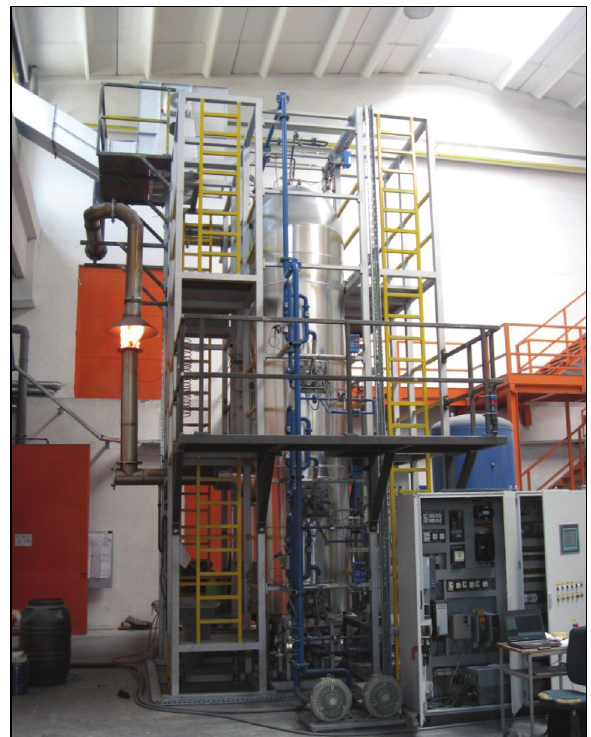
Fig. 2. The 750 kW semi-industrial plant. Photo courtesy of Bosio d.o.o. Author: Jernej Mele.